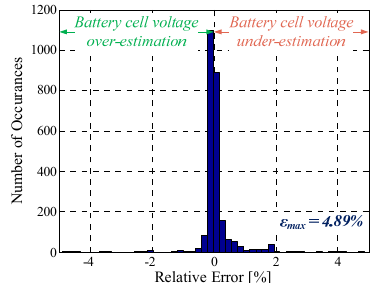
Figure 24. Distribution of the relative error obtained during dynamic pulse charging and discharging verification case.